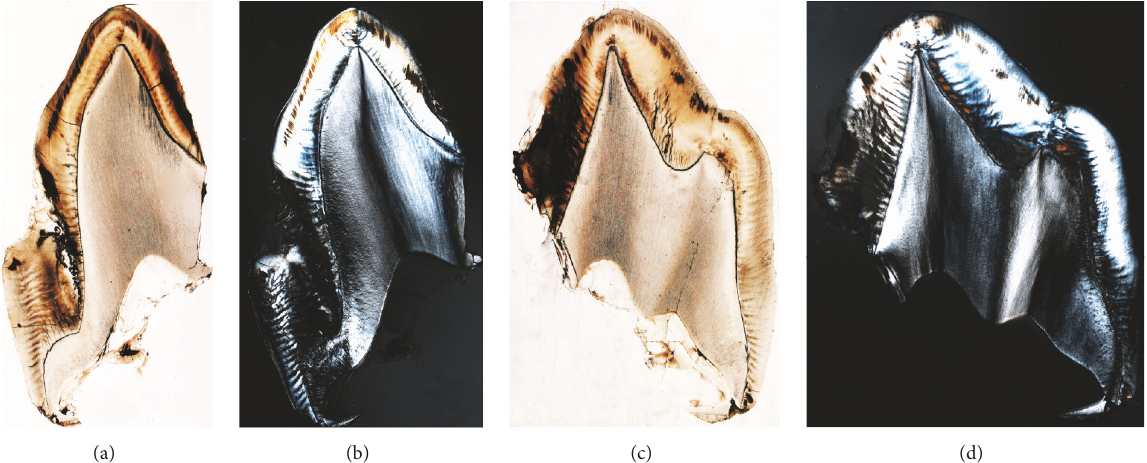
Figure 5: The ground sections of tooth A (a-b) and tooth B (c-d) under light microscope (a, c) and polarized microscope (b, d). The sections are not stained and polarization highlights mineralized tissue. Enamel appears more birefringent than dentine due to its higher level of calcification.